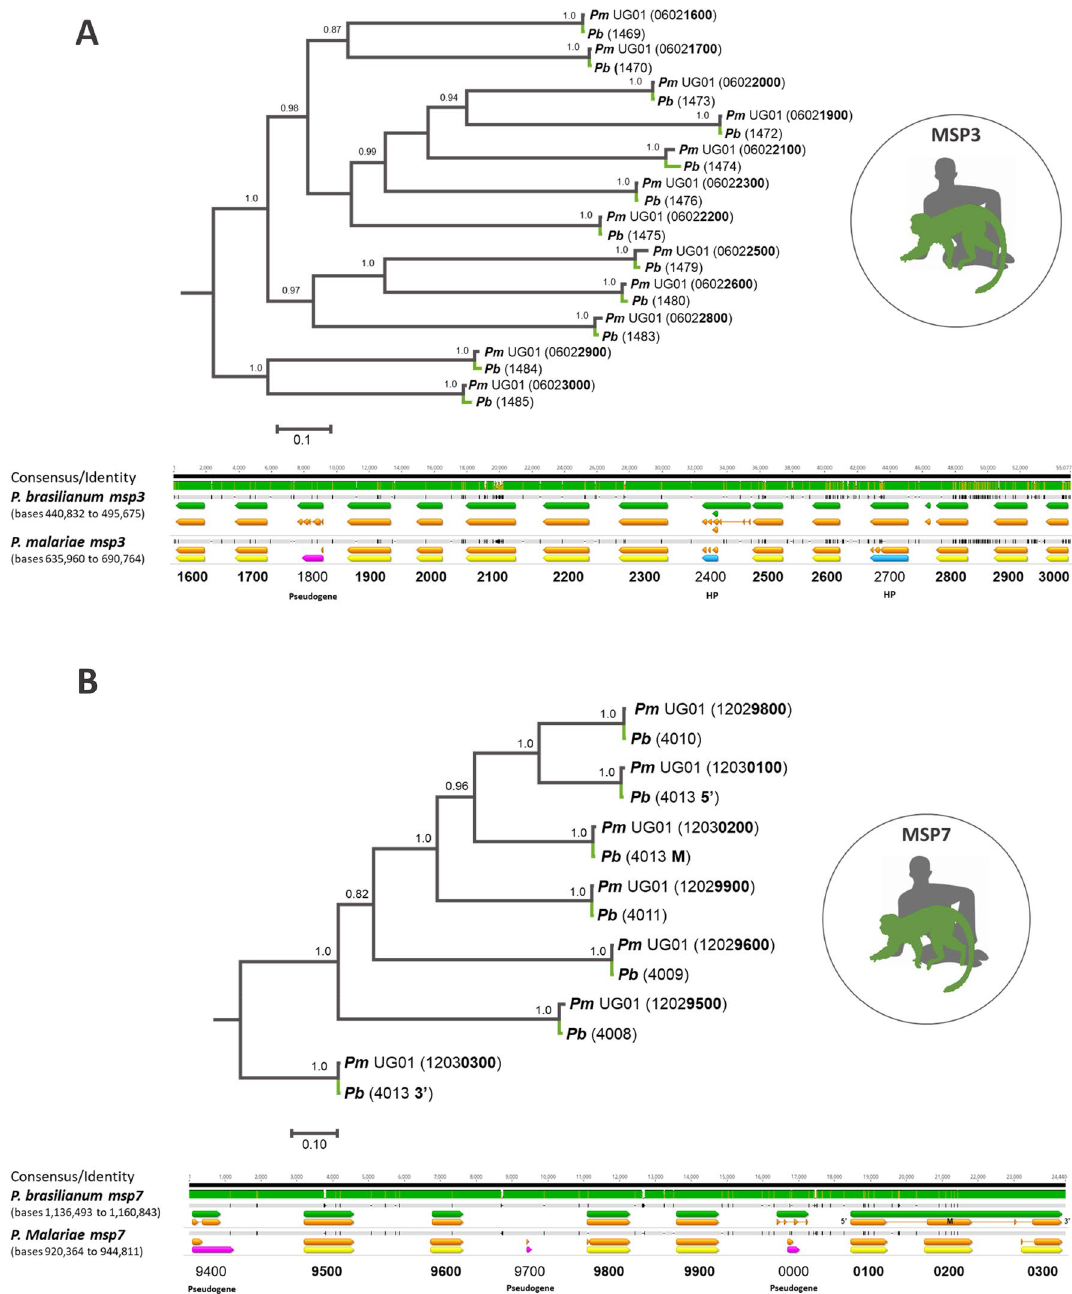
Figure 5. Phylogenetic distances and genome organization of msp3 and msp7 regions. Multiple sequence alignment was performed using members of the merozoite surface protein ( msp ) genes and a phylogenetic tree was generated using the Bayesian method implemented in MrBayes v3.2.6. ( A ) Phylogenetic tree (top) from a sequence alignment using 12 P. malariae msp3 genes and their corresponding sequence matches in P. brasilianum . Branches from P. malariae genes are grey with their unique ID label shown in bold, and branches from P. brasilianum are green. Genome browsers snapshot (bottom) of the msp3 region from both species. Genes demonstrated in the phylogenetic tree are in bold. Consensus between the two genomes is shown at the top of the browser shot with differences depicted as dips in the green heatmap and as black marks in the grey tracks for each species. ( B ) Phylogenetic tree (top) and genome browser snapshot (bottom) from a multiple sequence alignment using 6 P. malariae msp7 genes and their corresponding sequence matches in P. brasilianum . ( Pm = Plasmodium malariae , Pb = Plasmodium brasilianum ; Green = P. brasilianum genes, orange = coding sequences, yellow = P. malariae protein coding genes, pink = P. malariae pseudogenes, blue (HP) = P. malariae hypothetical proteins; 5 ′ = 5 ′ end coding sequence, M = middle coding sequence, 3 ′ = 3 ′ end coding